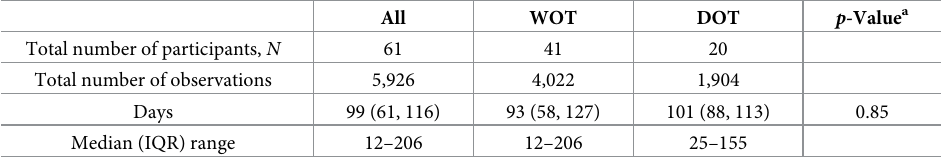
Table 2. Treatment duration (days) in Stage 2 for the entire cohort and by treatment arm. All